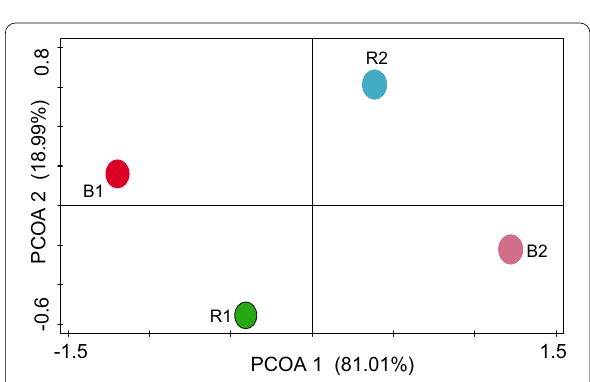
Fig. 2 PCoA of the bacterial components (at the order level) of sunflower rhizosphere and bulk soils obtained from Ditsobottla and Kraaipan farms using Canonical correspondence analysis. PCoA principal coordinates analysis; R1 Ditsobottla rhizosphere soil; B1 Ditsobottla bulk soil; R2 Kraaipan rhizosphere soil; B2 Kraaipan bulk